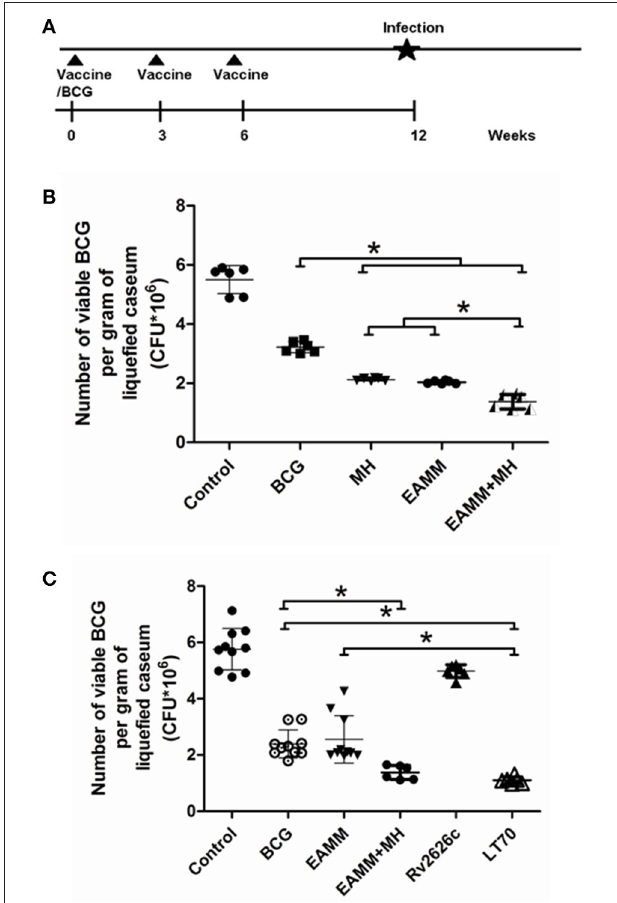
FIGURE 4 | The number of viable BCG per gram of liquefied caseum at the time the liquefaction peaked. The liquefied caseum of the rabbit skin lesions was obtained at the time when the liquefaction peaked and the number of bacilli per gram of liquefied material was determined. The schematic for the vaccine evaluation is shown in (A) . In the first vaccination trial, we evaluated BCG and the vaccine candidates EAMM, MH, EAMM-MH (B) . Then, we evaluated BCG, Rv2626c, EAMM, EAMM-MH, and LT70 in the second vaccination trial (C) . The means and their standard errors are shown. * P <